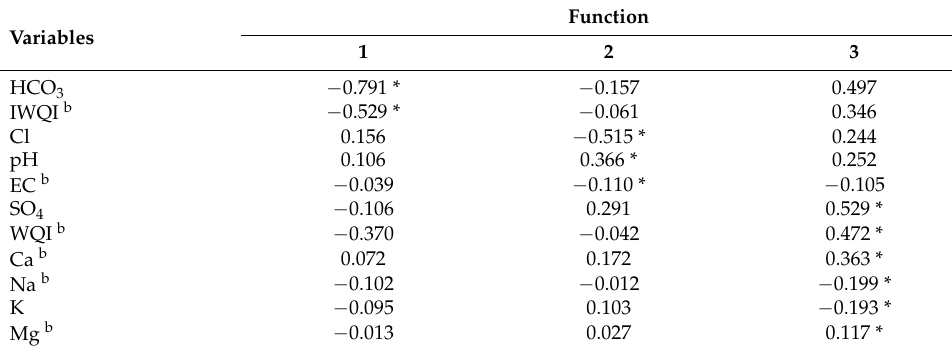
Table 11. The structure matrix for the discriminant analysis.